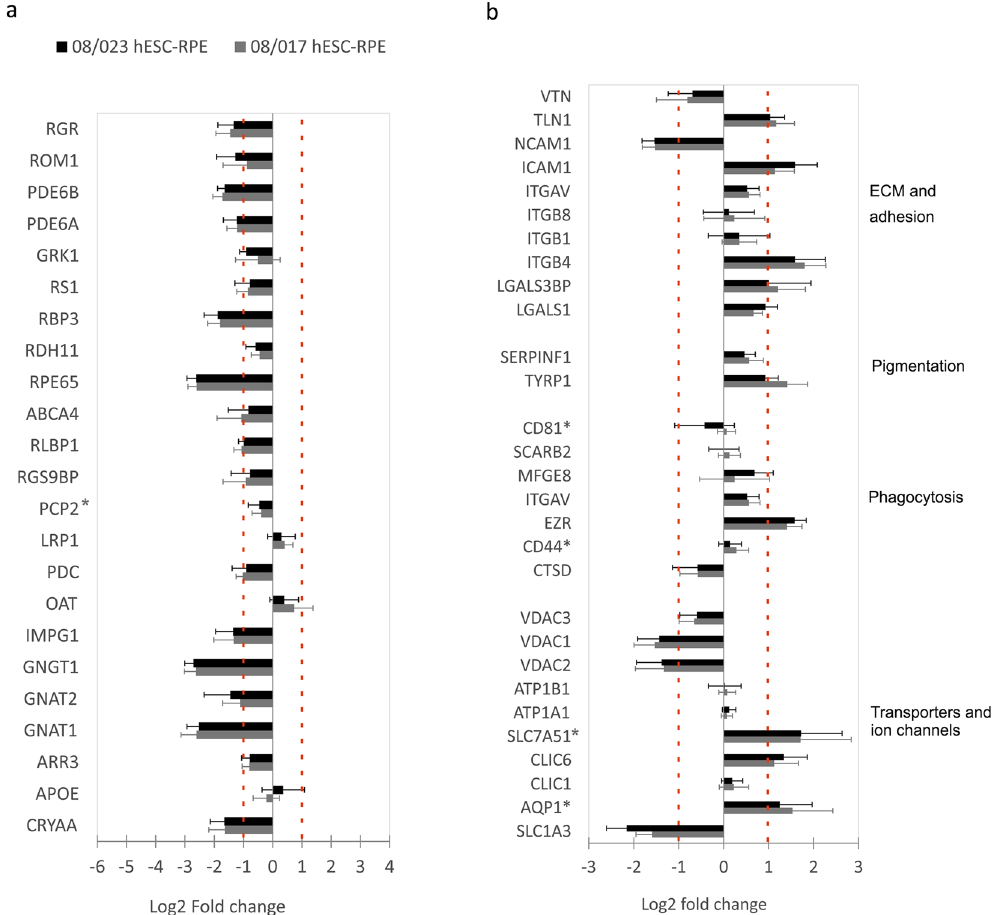
Figure 5. Proteins involved in important RPE functions. ( a ) Relative mean expression levels of the 23 proteins involved in perception of light stimulus and ( b ) of selected important RPE proteins. Protein expression levels shown on log 2 scale. Red dashed lines mark the borders for overexpression and underexpression (over 2-fold difference in expression). Error bars denote standard deviation. For the full protein names and expression values see Supplementary Table S8. * Quantification based on less than two